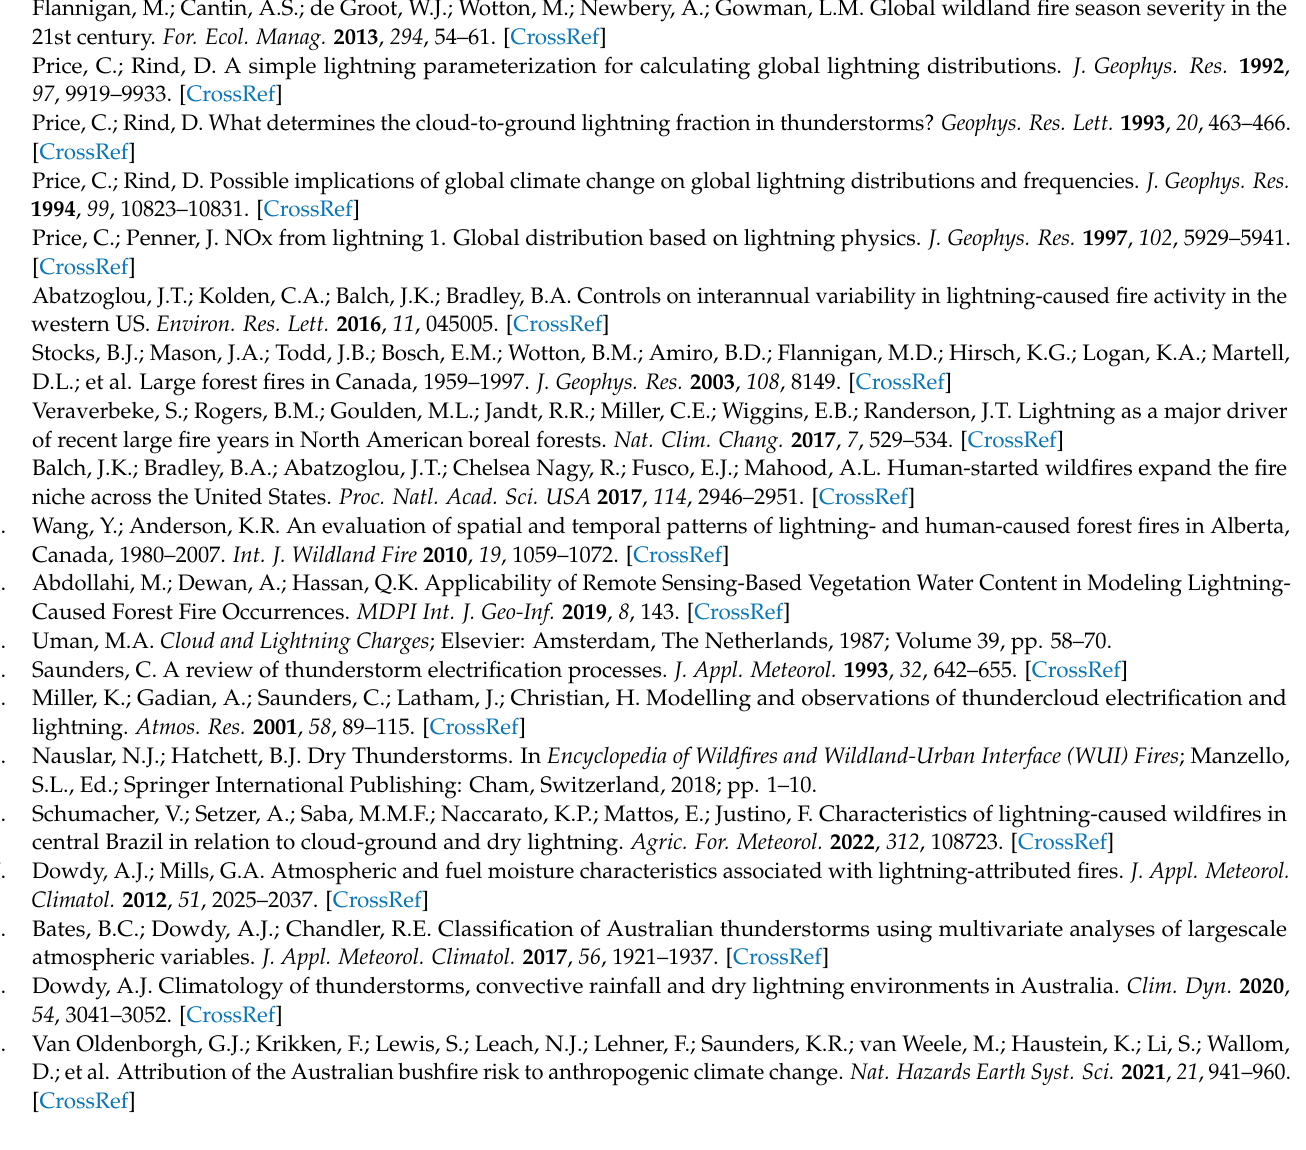
indicate the lightning flashes. Table S1: The Australia MODIS land cover vegetation quotes (2018) according by the International Geosphere Biosphere Programme (IGBP) legend and class descriptions; Table S2: The monthly distributions of Australian MODIS Terra wildfires, 2017–2020; Table S3: The monthly distributions of Australian MODIS Aqua wildfires, 2017–2020; Table S4: The differences between the numbers of Australian Aqua and Terra wildfires, 2017–2020; Table S5: The LIS ISS and MODIS parameters for lightning-caused wildfire event (29 October 2017), presented in Figure 10a; Table S6: The LIS ISS and MODIS parameters for lightning-caused wildfire event (17 December 2017), presented in Figure